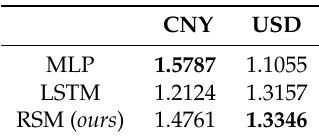
Table 3. The profitability factor of BTCCNY and BTCUSD in the OkCoin market. BTCCNY and BTCUSD prices showed two bubble bursts (Figures 3 and 4). The values are exponentials of the log return accumulated from trades. Market reference values were 1.5643 for BTCCNY and 1.4122 for BTCUSD (a value of 1 represents 100% of the initial investment). Refer to the text for